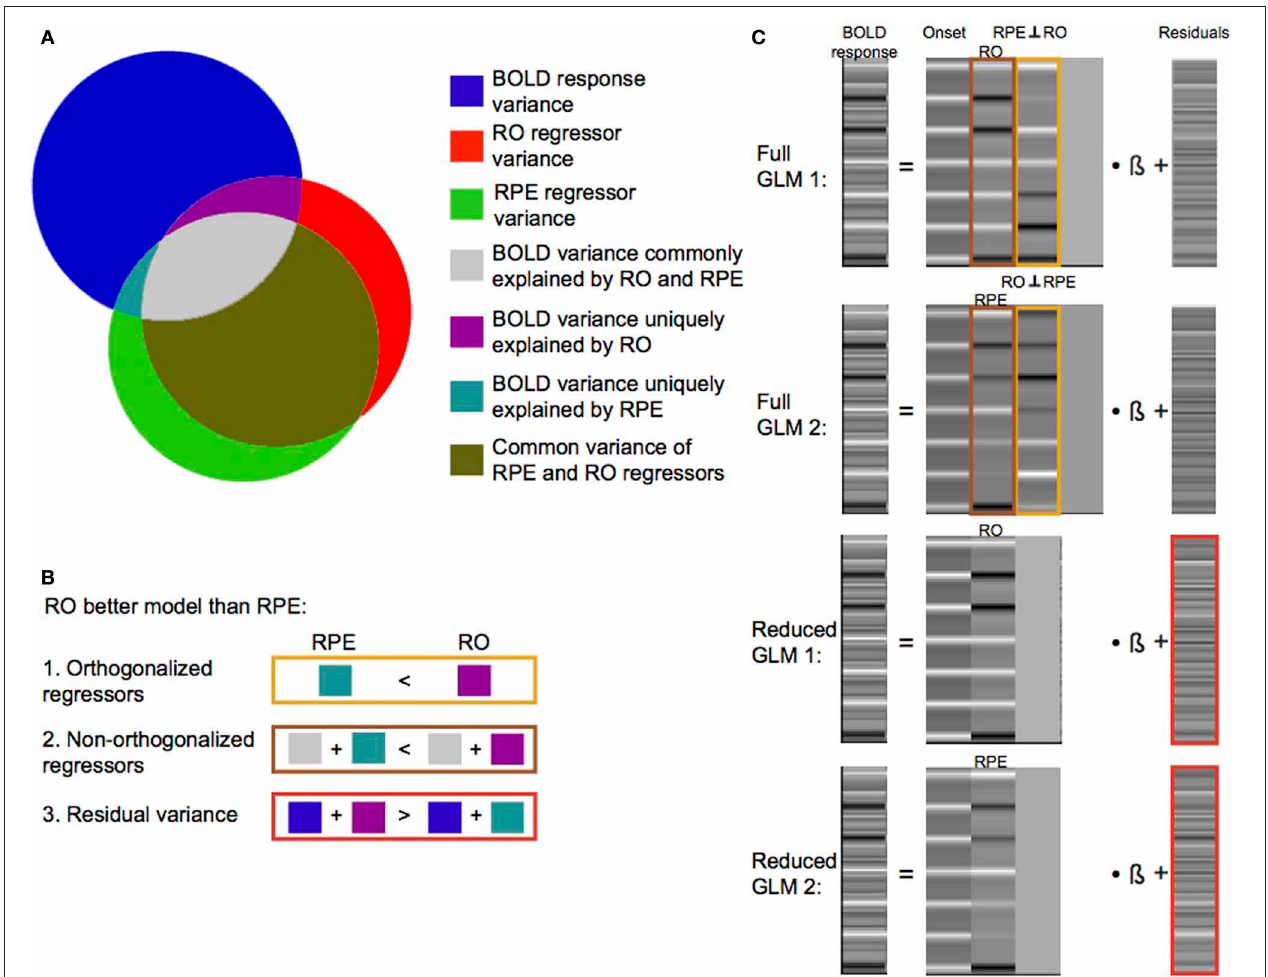
FIGURE 1 | Illustration of the three model comparison approaches. (A) The areas of three overlapping circles correspond to unique and common variance of the dependent variable (BOLD response) and the two candidate regressors (RO vs. RPE). In this example, the RO model is a better model of the region’s BOLD response than the RPE model. This can be inferred from three equivalent comparisons. (B) First, the comparison of BOLD variances uniquely explained by the orthogonalized regressors shows that the RO model explains more BOLD variance than the RPE model. Second, the comparison of the BOLD variances uniquely and commonly explained by the